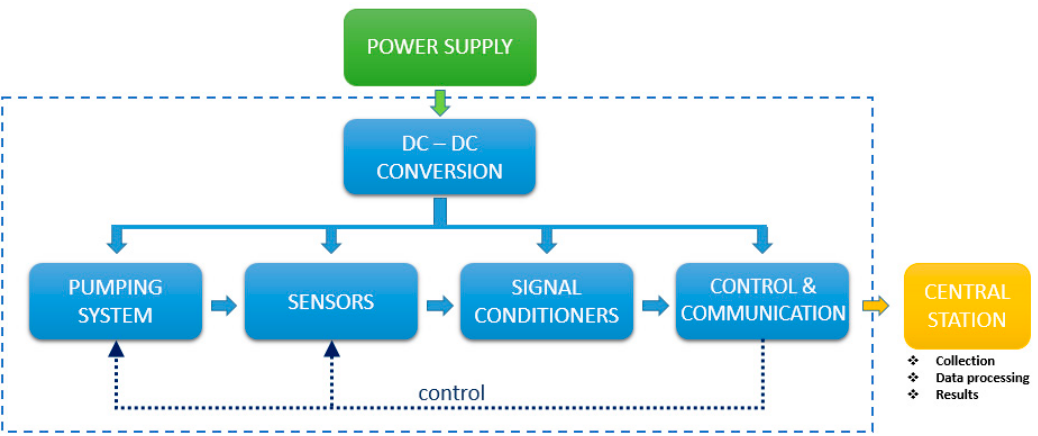
Figure 1. Block diagram of each node of the WSN.